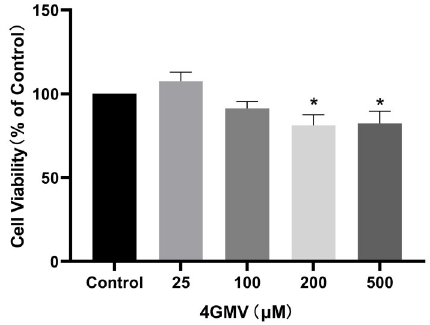
Figure 4. Effect of different concentrations of 4 ’ -O- b -D-glucosyl- 5-O-methylvisamminol (4GMV) (0, 25, 50, 100, 200, 500 m M) on cell viability in RAW 264.7 cells was detected by CCK-8 assay. Data are reported as means ± SD from three independent experiments (n=3). *P o 0.05 compared with the control group (ANOVA followed by LSD).